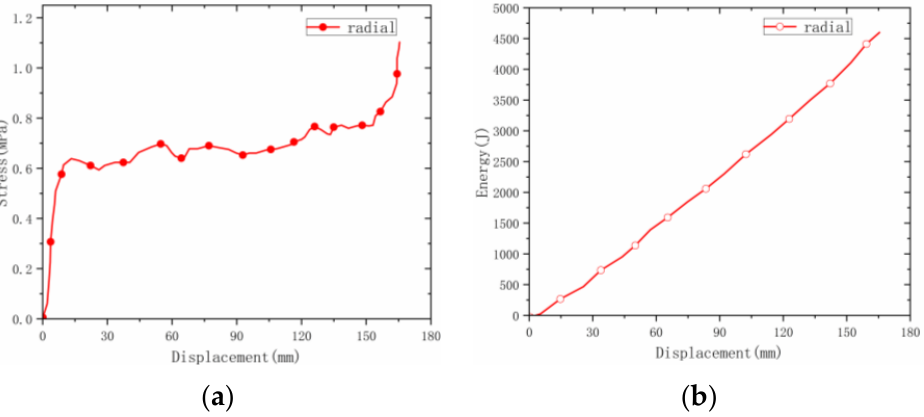
Figure 7. Lateral stress – displacement and energy-absorption curves of welded origami honeycomb 1. ( a ) Stress – displacement curve. ( b ) Energy – displacement curve.